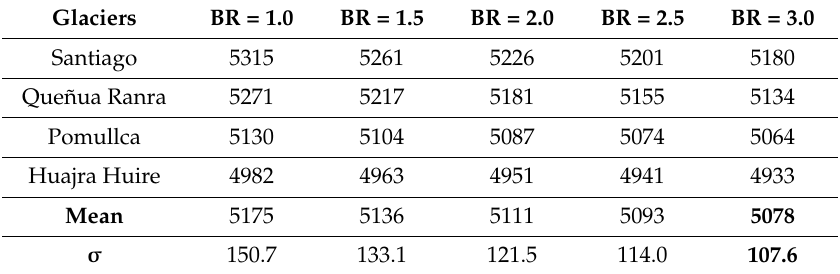
Table 3. PaleoELA 1 : glaciers from source areas >5250 m (Coropuna summits) and BR applied. Glaciers BR = 1.0